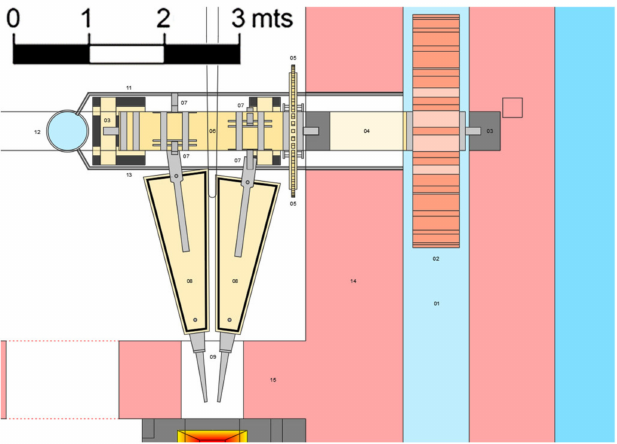
Figure 13. Detail of the bellows room of the forge. Source: own elaboration.